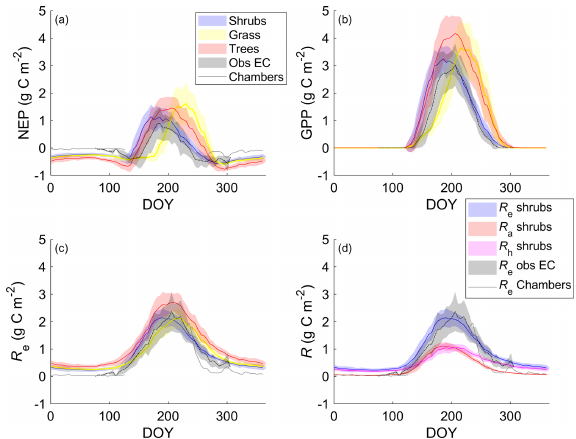
Figure 6. Mean 5d average (a) net ecosystem productivity (NEP), (b) gross primary productivity (GPP), and (c) ecosystem respiration ( R e ) for the shrub, grass, and tree simulations alongside EC tower- based observations. (d) Simulated R e broken down into its compo- nent fluxes, autotrophic ( R a ) and heterotrophic respiration ( R h ), for the shrub simulation averaged over 2004–2017. Observed NEP (a) and R e (c, d) include both EC measurements during the growing and shoulder seasons averaged over 2004–2017 and chamber mea- surements made between August 2018 and May 2019. Shaded areas show the standard deviation of the daily mean for 2004–2017.